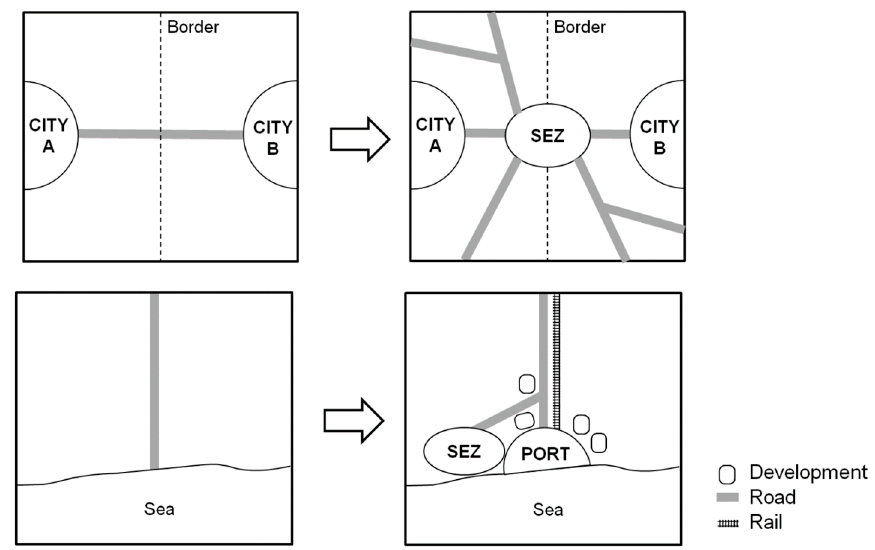
Figure 4. Examples of temporal sequentiality of BRI infrastructure development.